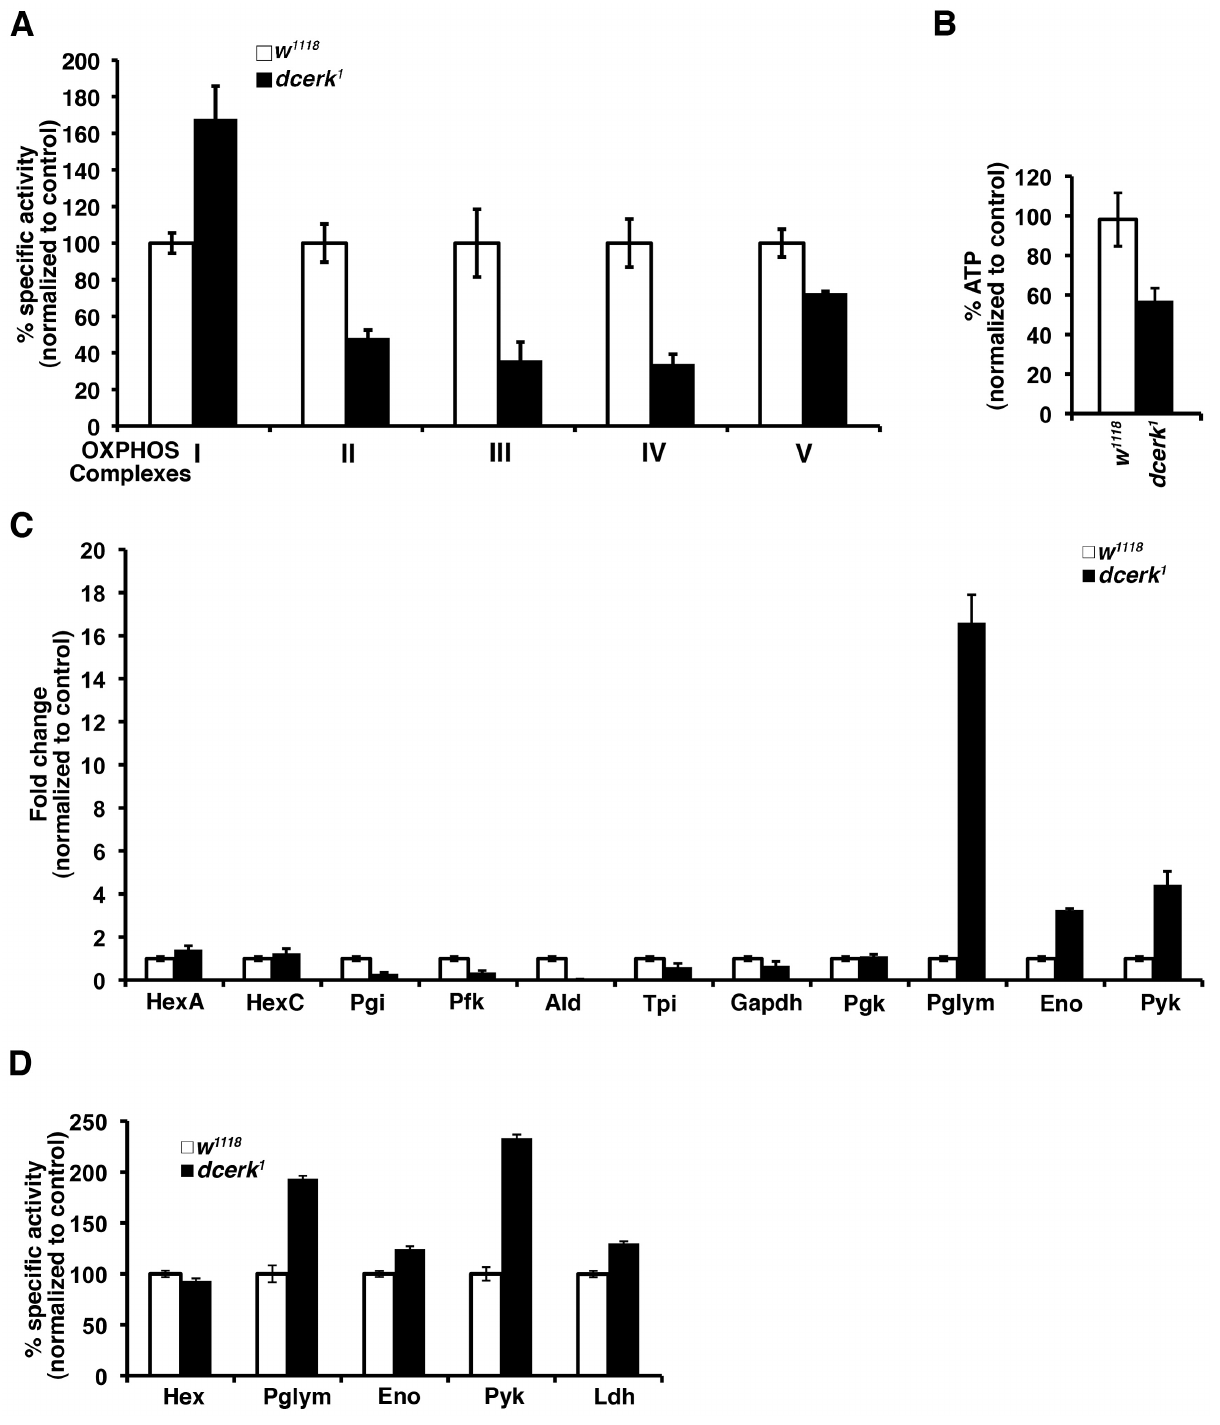
Figure 2. dcerk 1 mutants show decreased mitochondrial oxidative phosphorylation, lower ATP level, and increased glycolysis compared to control flies. (A). The activity of each of the electron transport chain complexes is measured spectrophotometrically using specific substrates and inhibitors in mitochondria isolated from control and mutant flies. Specific activity per mg of mitochondrial protein was calculated and then normalized to w 1118 . Mitochondria were prepared from 1000 flies and 3 replicates were carried out. Error bars represent standard deviation. (B). ATP level is measured in w 1118 and mutant fly mitochondria by a bioluminescence assay using luciferase catalyzed oxidation of luceferin which is ATP dependent. The amount of ATP is calculated per mg of mitochondrial protein and normalized to w 1118 . The relative level of ATP in the mutant mitochondria is 60% of w 1118 . n=3, error bars represent standard deviation. (C). QPCR analysis of transcripts encoding glycolytic enzymes show a 16– 18 fold increase in Pglym, 3–4 fold increase in Eno and 4–5 fold increase in Pyk levels in dcerk 1 relative to w 1118 . n=3, error bars represent standard deviation. (D). Measurement of specific activities of glycolytic enzymes show increase in Pglym, Eno, Pyk and Ldh activities of dcerk 1 compared to w 1118 while that of hexokinase is not significantly different. Specific activity of each enzyme is determined per mg of protein and then normalized to w 1118 . n=3, error bars represent standard deviation. doi:10.1371/journal.pgen.1003556.g002 PLOS Genetics |